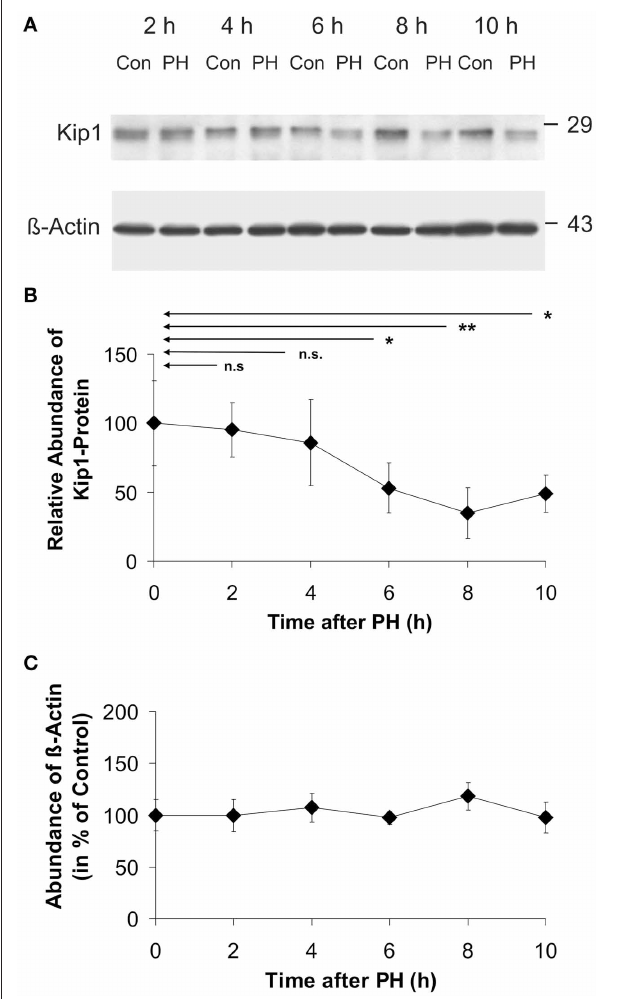
FIGURE 3 | Abundance of p27Kip1 or β -actin in residual liver tissue at different times after partial hepatectomy. (A) Representative Western blots (using p27Kip1-specific or β -actin-specific monoclonal antibodies) of protein extracts from rat liver control samples (Con: tissue obtained during initial surgery) and in residual liver tissue at different times after PH (PH). The marks on the right show the positions of the protein standards with molecular masses as indicated. (B) Densitometric signals obtained from Western blots using equal amounts of protein extracted from the tissue samples as described in the legend to A and p27Kip1-specific monoclonal antibodies, normalized to the respective β -actin signals. (C) Densitometric signals obtained from Western blots using β -actin-specific monoclonal antibodies. Data in (B) and (C) are expressed as percentages of the control values at 0h. The data points represent means ± SD of n = 4 different preparations of tissue, each analyzed at least in triplicate (n.s., p ≥ 0 . 05; ∗ p < 0 . 05; ∗∗ p < 0 . 01). No significant differences in β -actin abundance were detected in residual liver tissue of hepatectomized animals (C)